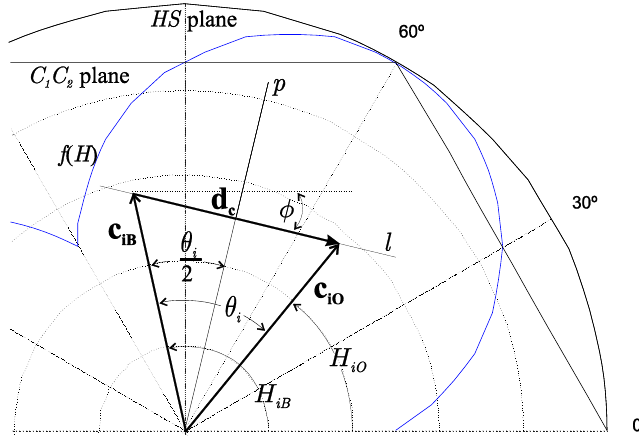
Figure 4. Location of the vectors c been